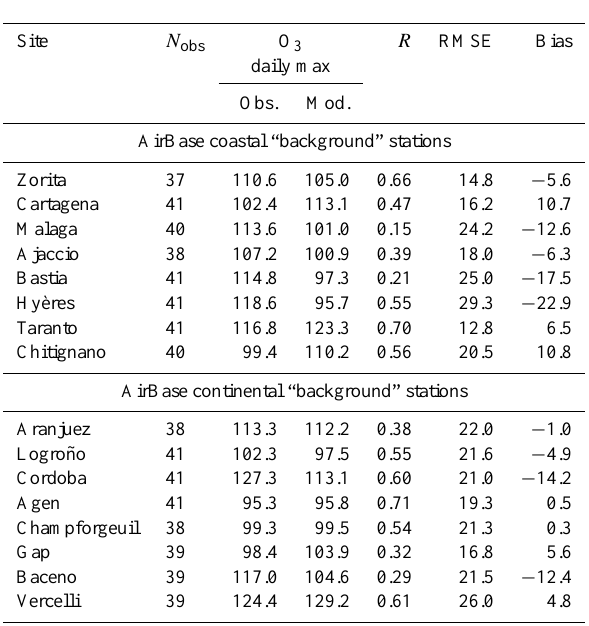
Table 6. R , RMSE and bias of measured and modeled daily maxi-